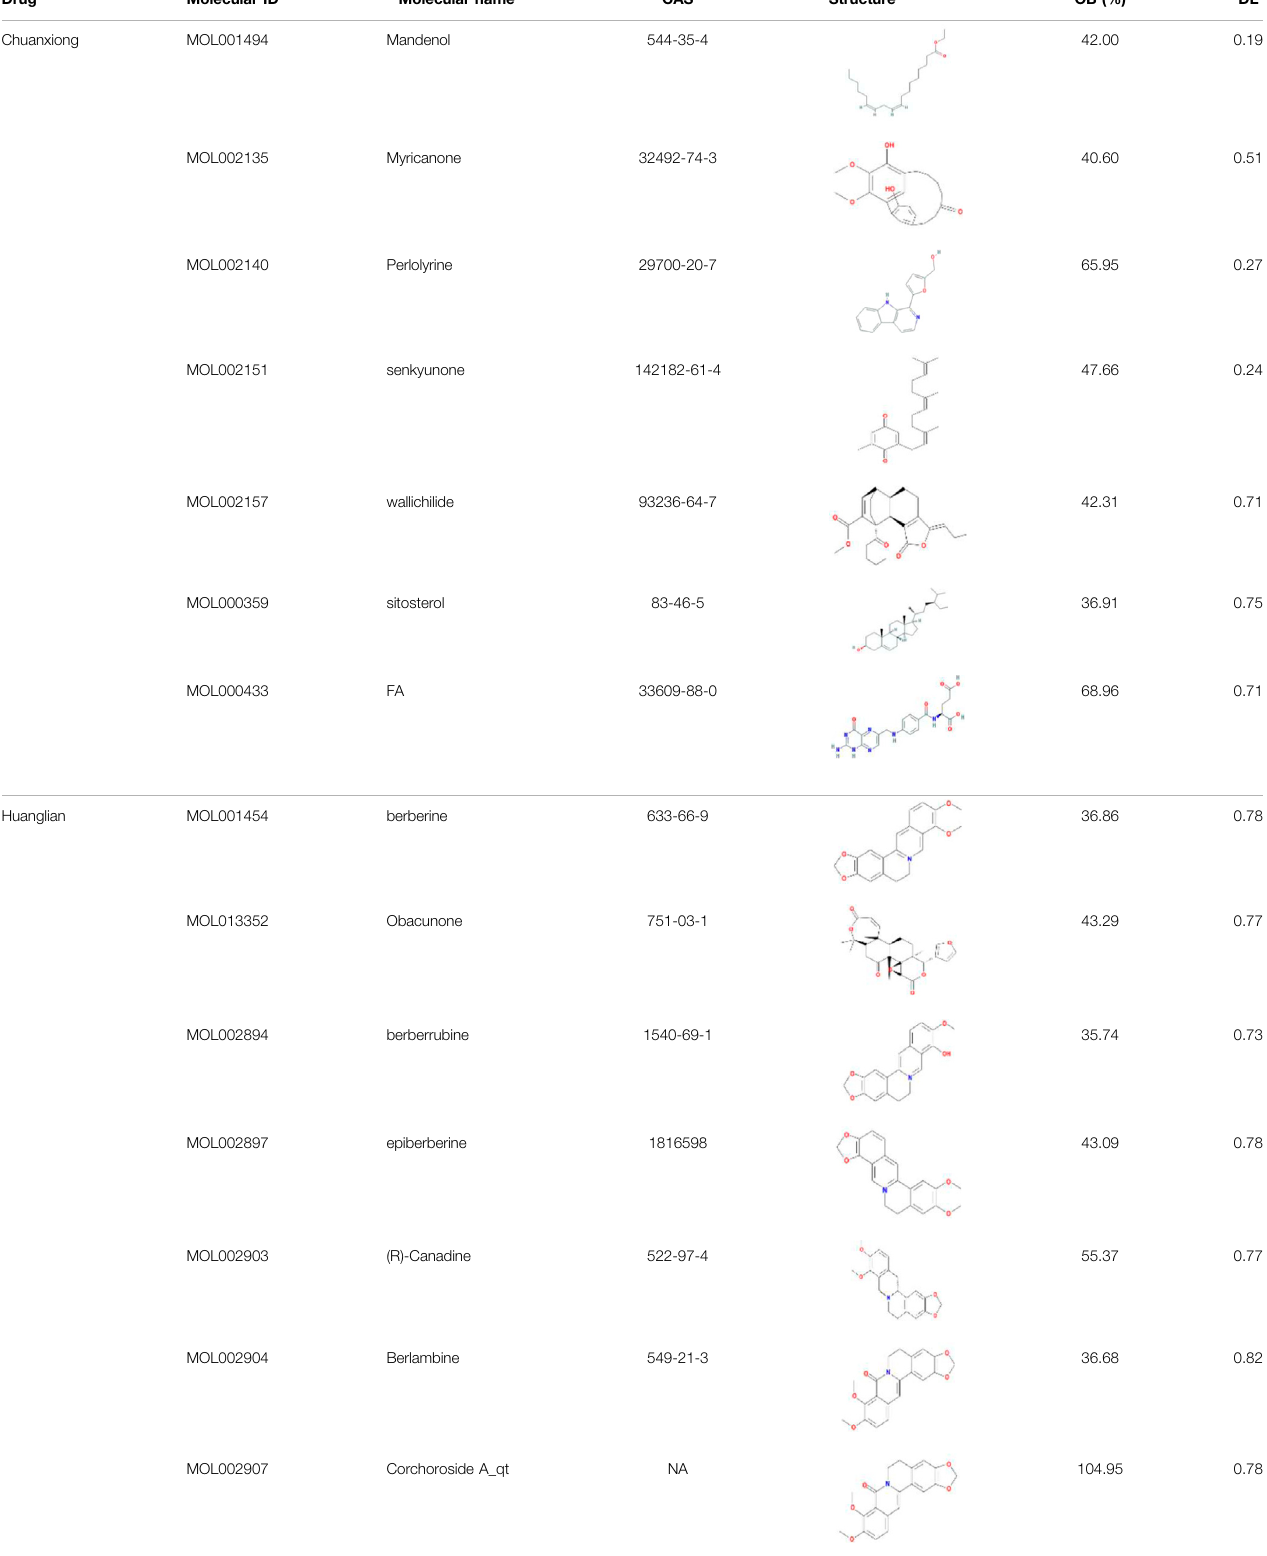
TABLE 1 | The fi nal selected ingredients in YZQX for analysis.